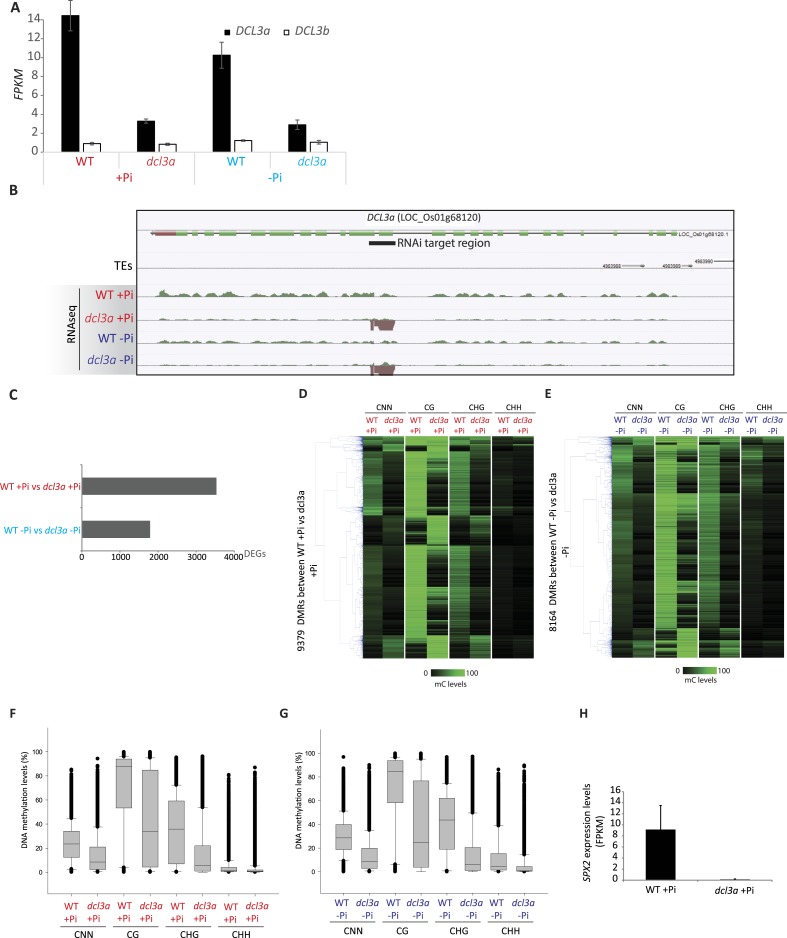
Down-regulation of DCL3a.